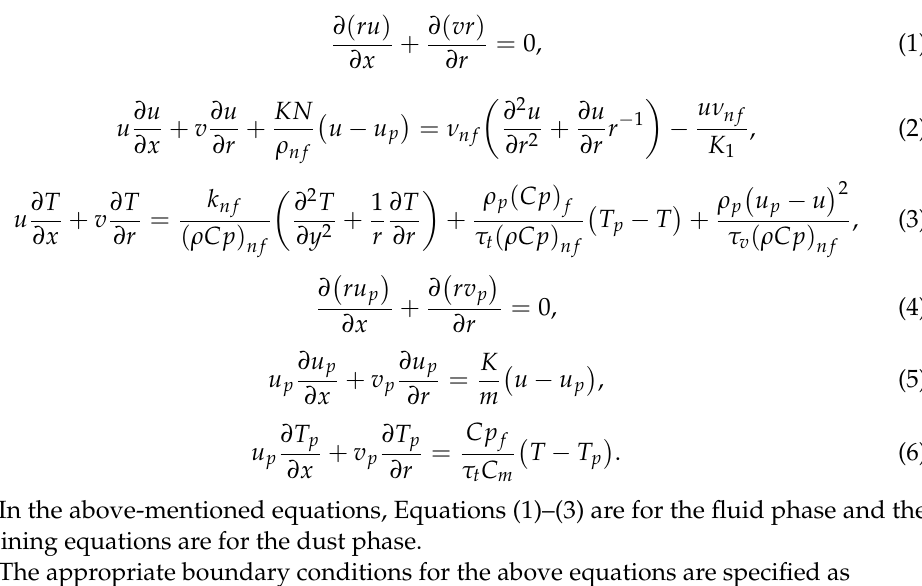
In the above-mentioned equations, Equations (1)–(3) are for the fluid phase and the remaining equations are for the dust phase. The appropriate boundary conditions for the above equations are specified as